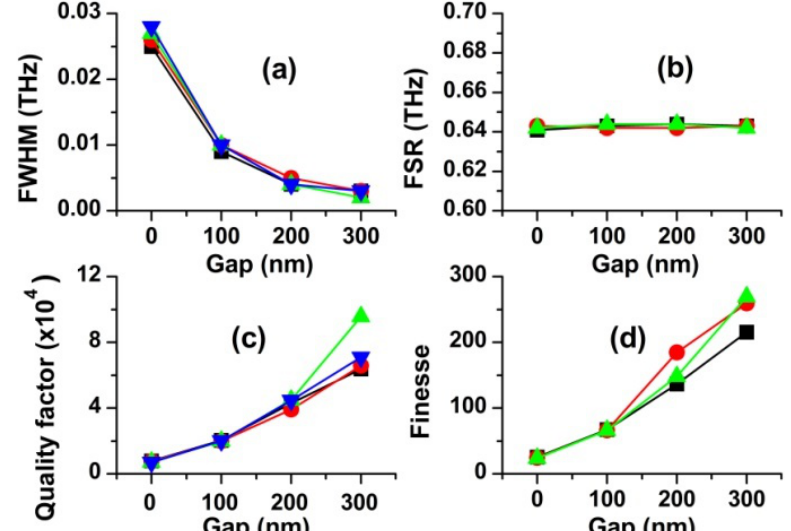
Figure 9. Effects of the gap width on the resonance characteristics (d = 100 μ m, t = 3 μ m, w = 2 μ m). Displayed four data sets are obtained from adjacent resonance peaks,